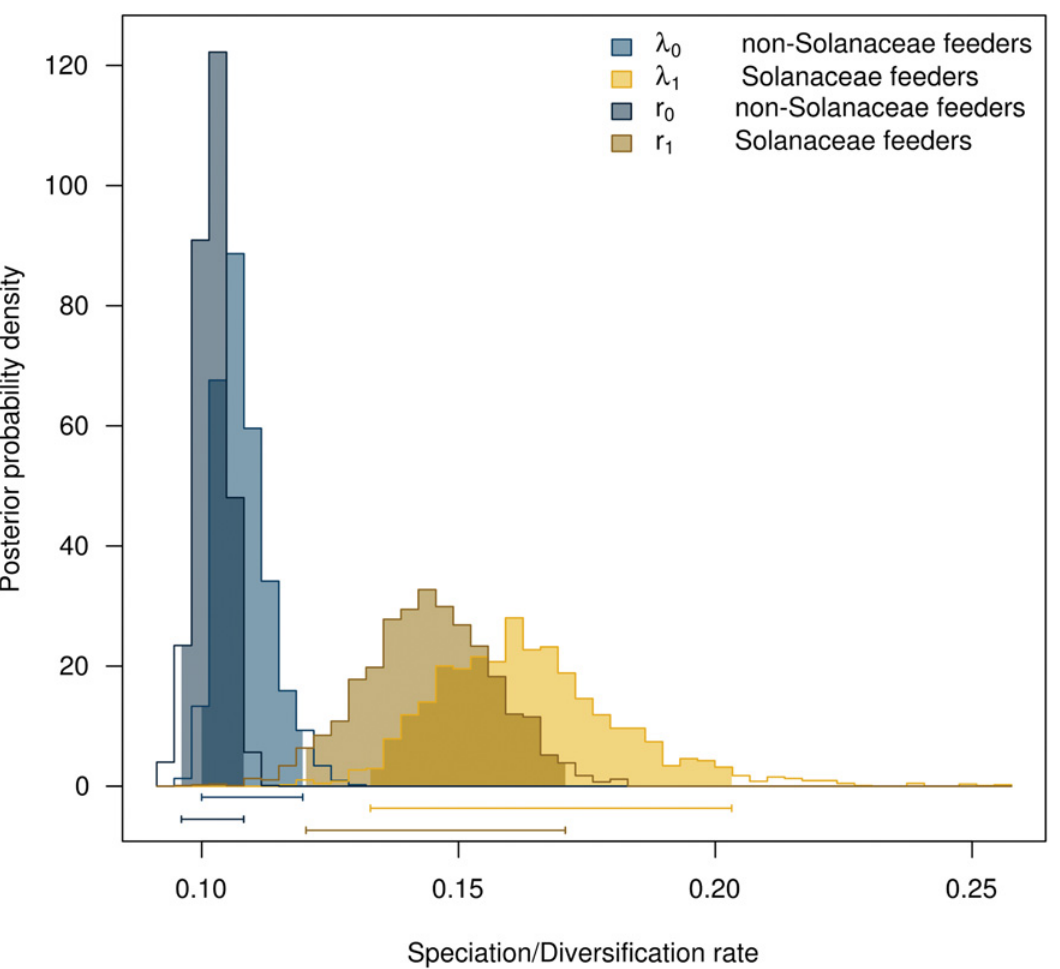
Fig 4. BiSSE analysis of diversification of nymphalids due to feeding on Solanaceae hostplants. Speciation and net diversification rates are significantly higher in Solanaceae feeders (speciation rate = λ 1, net diversification rate = r 1)